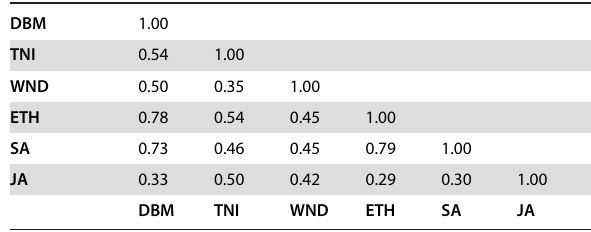
All p , 0.001 with Bonferroni correction. Analyses are based on mean changes in expression between induction and control treatments at nine hours for 212 genes (see Materials and Methods for details).